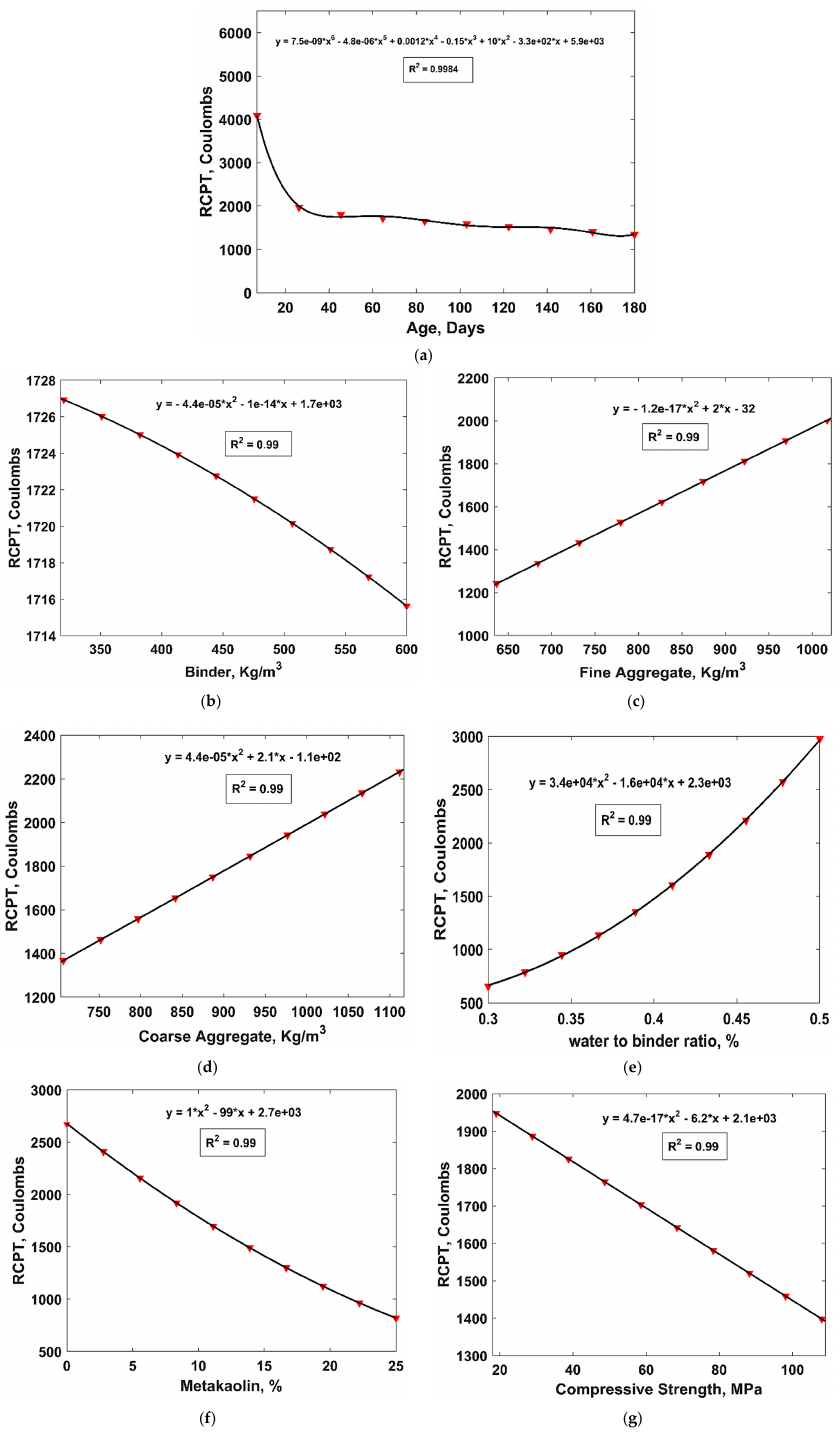
Figure 10. Parametric analysis of input variables. ( a ) age, ( b ) binder, ( c ) Fag, ( d ) Cag, ( e ) w/b ratio, ( f ) MK, and ( g ) compressive strength.